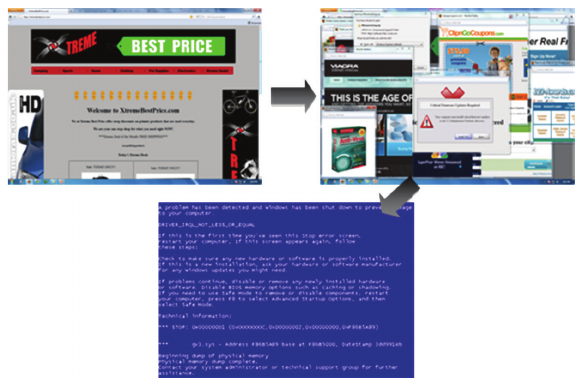
Figure 3: Screenshots of the day four manipulations. Figure 3(a) shows the homepage of xtremebestprice.com, 3(b) shows the pop- ups that occur on the site, and 3(c) shows the “blue screen of